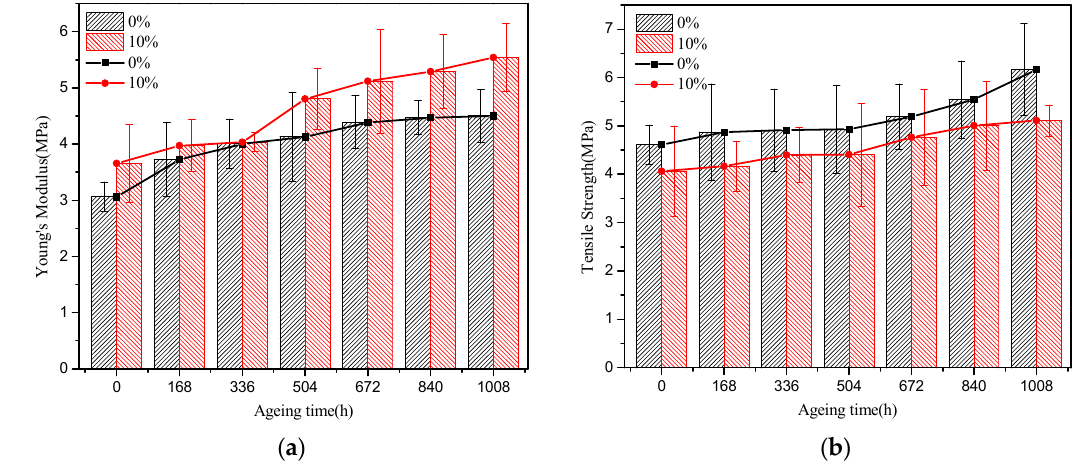
tensile strength increment of pure silicone samples is higher than that of phosphor/silicone composites, especially at the end of ageing. This can be explained as the reason that the moisture induced hydrolysis of phosphor powders increased their surface roughness, resulting in the uneven contact between phosphor particles and the silicone. This might produce gaps between them and slow down the tensile strength increment rate of composite.